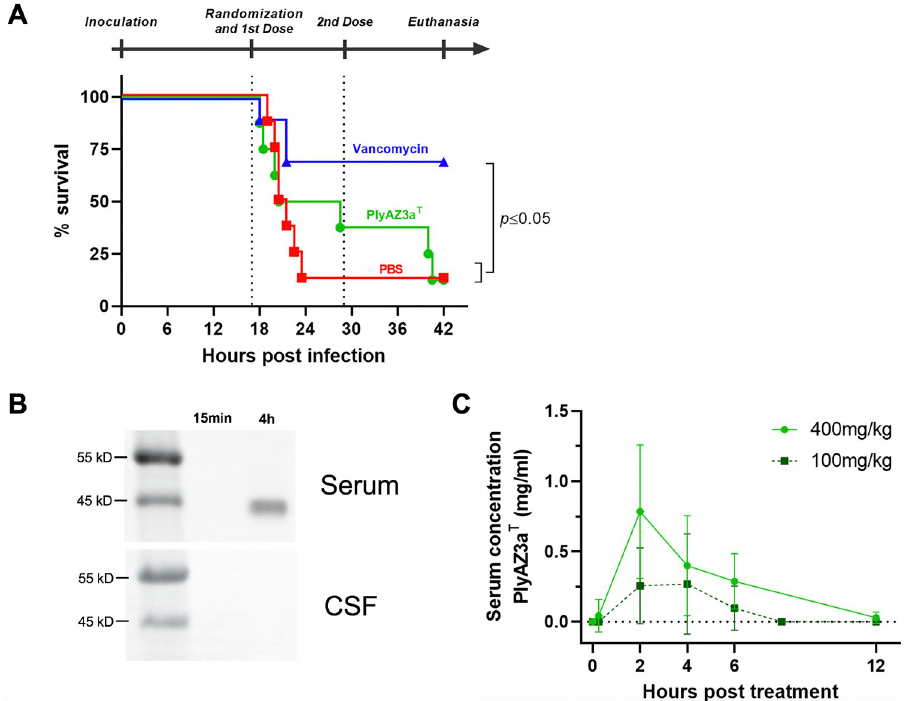
Fig 2. Treatment of ceftriaxone-resistant pneumococcal meningitis using PlyAZ3a T . (A) Kaplan-Meier survival curve of Wistar rats treated with either PBS (n = 8), 400 mg/kg PlyAZ3a T (n = 8) or 50 mg/kg Vancomycin (n = 10). Treatment was applied intraperitoneally twice daily. Significance was determined by log-rank test. (B) Anti-PlyAZ3a T near-infrared western blots of serum or CSF samples recovered from one animal treated with a single intraperitoneal injection at 15 min and 4 h after injection. (C) Pharmacokinetic assessment of PlyAZ3a T in serum of Wistar pups (n = 16 per group) after one single intraperitoneal injection. Limit of detection 10 μ g/ml. Data are presented as mean ± standard deviation.